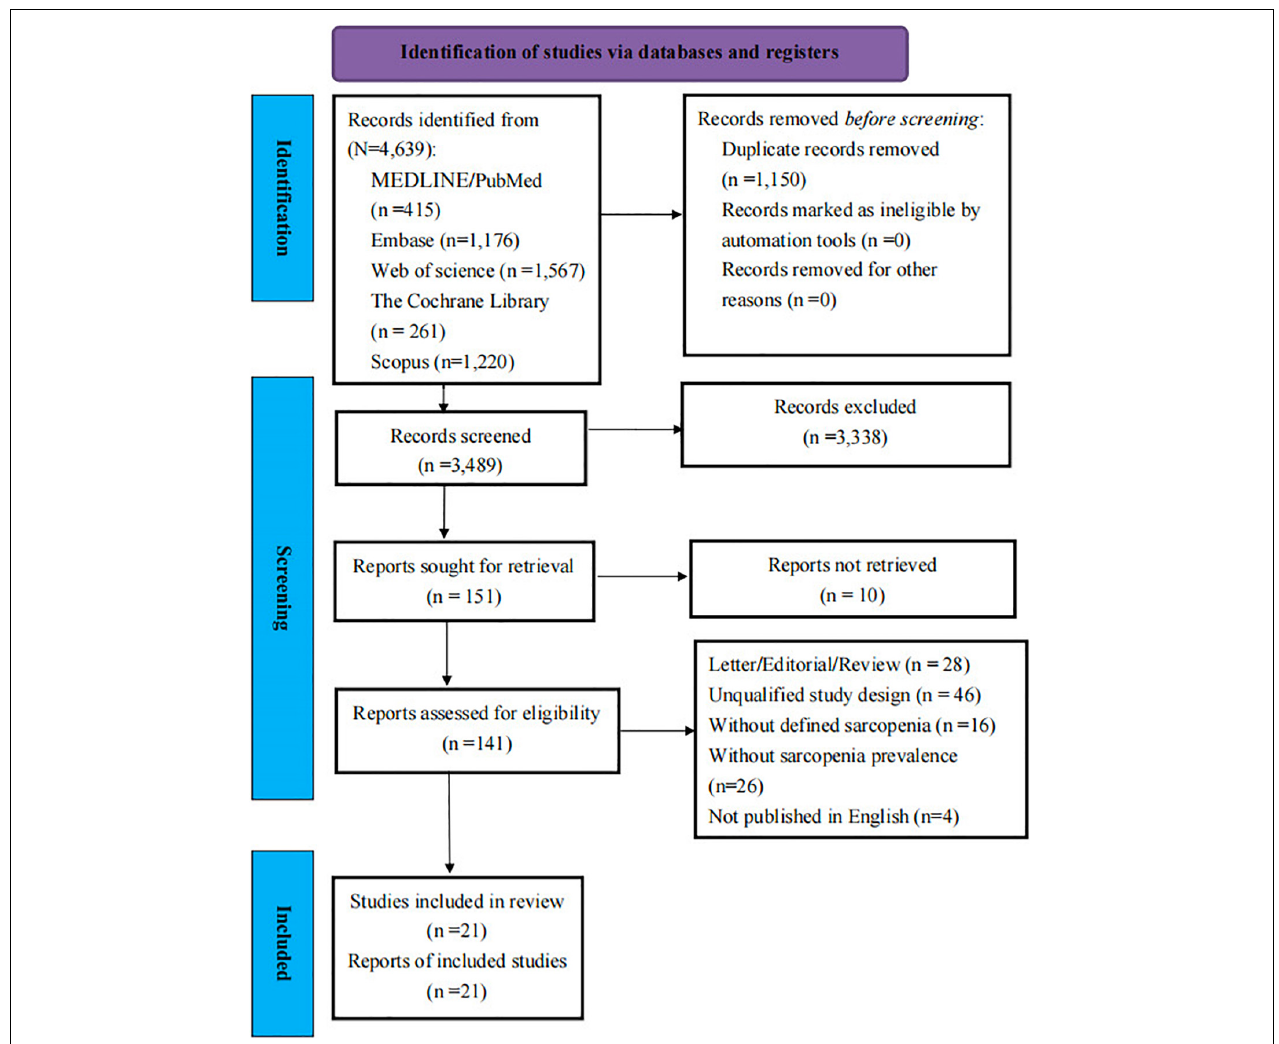
FIGURE 1 | PRISMA (2020) diagram of study screening and